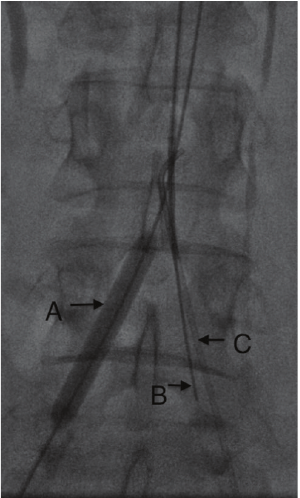
Figure 4: Spot image at the level of the aortic bifurcation showing an inflated angioplasty balloon occluding the recanalized right CIA at its origin (A), a stiff Glidewire advanced into the occluded left CIA from an antegrade brachial approach (B) and a 5 French angiographic catheter in the retrograde subintimal tract of the left CIA advanced from a ipsilateral femoral approach.